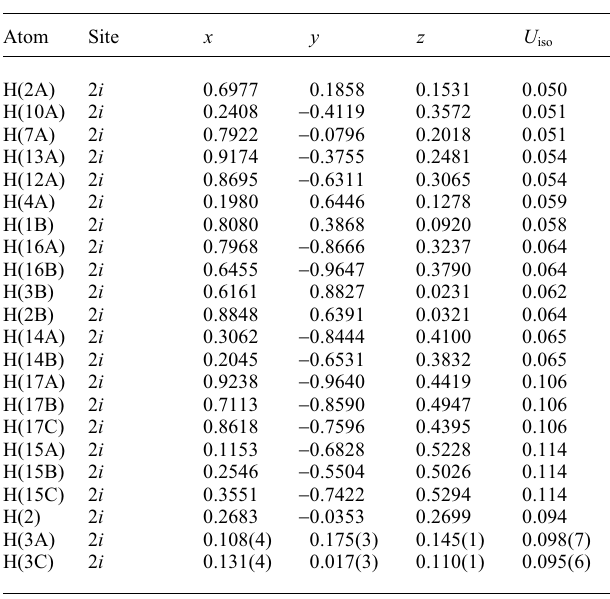
Table 2. Atomic coordinates and displacement parameters (in Å 2 )